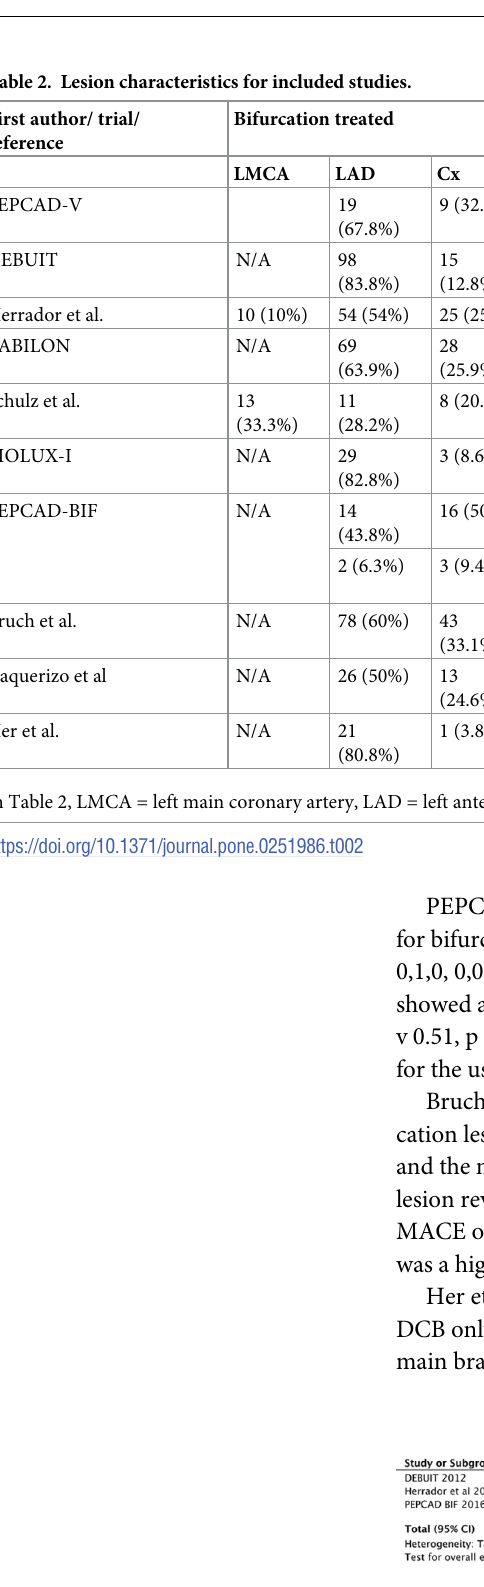
Table 2. Lesion characteristics for included studies.